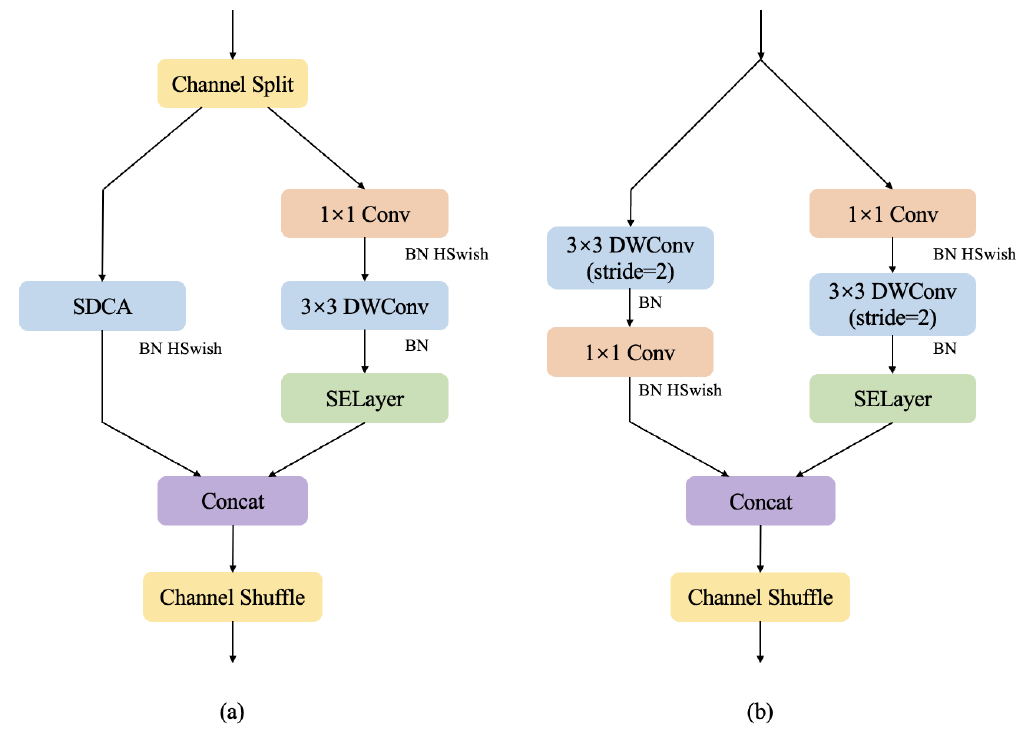
Figure 5. Improved ShuffleBlock. ( a ): the base unit with SDCA applied; ( b ): the base unit for down- sampling (2×).